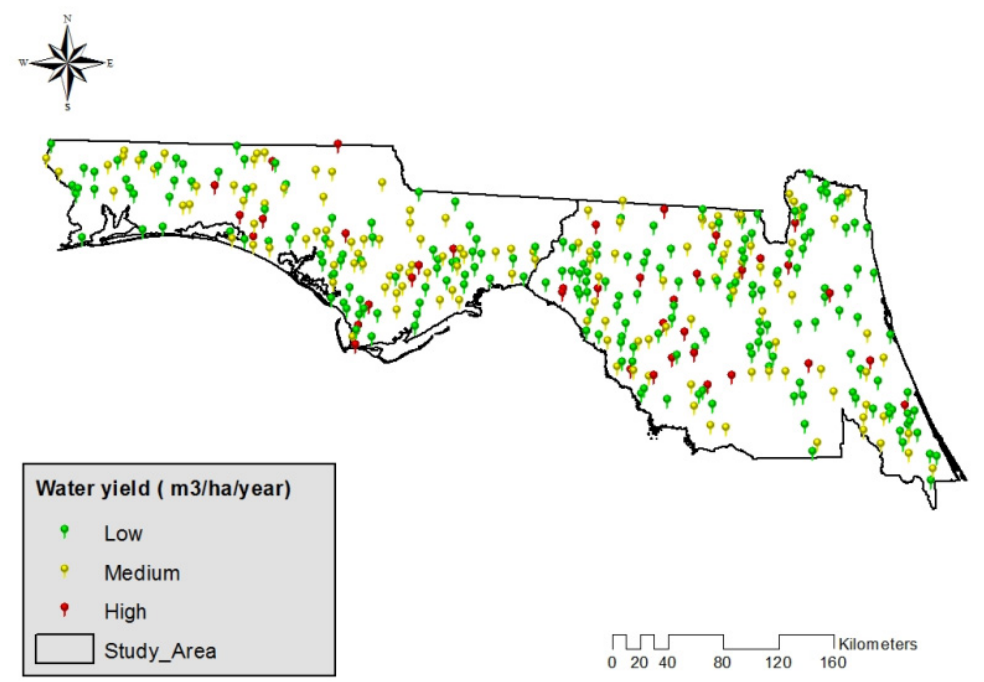
Figure 6. Water yield provision levels for forest inventory analysis (FIA) Pinus elliotti plots in Florida’s northeastern and northwestern survey units, 2002–2011.